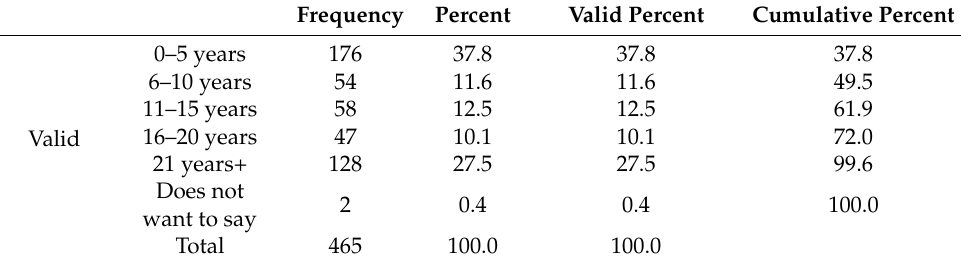
Table 4. Experience in the industry.